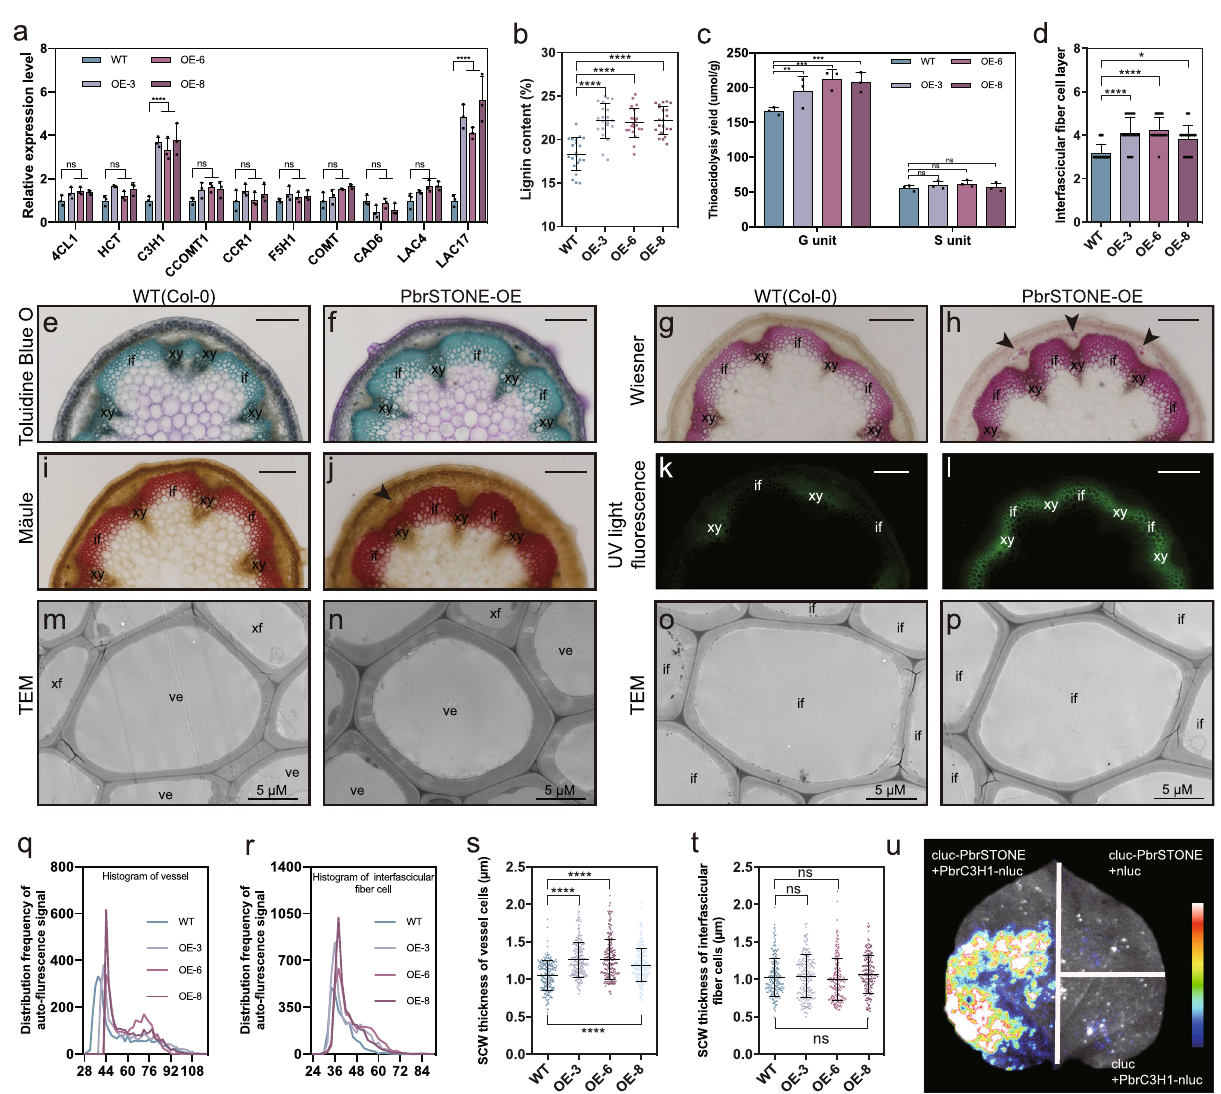
Fig. 6 Functional validation of PbrSTONE in Arabidopsis . a Expression levels of genes encoding enzymes involved in monolignol biosynthesis and polymerization in WT and PbrSTONE transgenic Arabidopsis plants using qPCR analysis; n = 3 biologically independent samples. b , c Lignin analysis for WT and PbrSTONE transgenic Arabidopsis plants; h: n = 21 biologically independent samples for b , and n = 3 for c . d Layers of stem interfascicular fi ber cells in transgenic Arabidopsis plants expressing PbrSTONE ; n = 16 biologically independent samples. e , f Cross-sections of 8-week-old in fl orescence stems stained with Toluidine blue O. g – j Cross-sections of 8-week-old in fl orescence stems stained with Mäule and Wiesner reagent, which bind to S-lignin monomer and G-lignin monomer, respectively. k , l Lignin auto- fl uorescence of cross-sections detected under UV light. Scale bars: 200 μ m in k – r . Bar in k – r = 200 μ m; xy, xylem; if, interfascicular fi ber cell. The transgenic and WT plants were cultivated two times and cross-sections were taken from fi ve independent plants which showed similar results. A representative picture from each line is shown. m – p Transmission electron micrographs of the cross-section of cells in e ; ve, vessel; xf, xylary fi ber; if, interfascicular fi ber cells. q , r Statistical analysis of lignin auto- fl uorescence signal in the vessel cells and interfascicular fi ber cells. More than 12 samples in each line were analyzed. s , t Statistical analysis of secondary cell wall thickness in the vessel cells and interfascicular fi ber cells. More than 50 cells in each line were analyzed. u Fire fl y luciferase complementation assay in young Nicotiana benthamiana leaves. Data presented are mean ± SD; p -values were determined by two-tailed Student ’ s t -test (* p < 0.05, ** p < 0.01, *** p < 0.001, **** p < 0.0001; ns, not signi fi cant). Source data underlying ( a – t ) are provided as a Source Data fi and the reads were then processed using Trimmomatic 41 to trim the adapters and using plant genomic DNA kits from TIANGEN ® . DNA quality was checked by NanoPhotometer ® spectrophotometer (IMPLEN) and 1% agarose gels, and DNA sequences with average quality per base below 20. The trimmed reads with length of at least 40bp were mapped against the reference pear genome 20 ( P. bretsch- concentration was measured by Qubit ® DNA Assay Kit in a Qubit 2.0 Flurometer (Life Technologies). NEB Next Ultra DNA Library Prep Kit for Illumina ® (NEB) neideri ) using BWA aln 42 with parameters ‘ -n 0.04 -o 1 -e 2 ’ . Genome Analysis was used to generate the sequencing libraries. The cBot Cluster Generation System Toolkit (4.1.4) was used for SNP calling with uni fi ed genotyper method 43 , and the of the HiSeq 4000 PE Cluster Kit (Illumina) was used for clustering of the index- SNPs were fi ltered using criteria of MAF ≥ 0.03 and missing rate no more than 30%. coded libraries, and the Illumina HiSeq 4000 system was used to sequence the DNA libraries (150 bp paired-end reads). F ST and ROD analysis and selective sweep detection . F ST and ROD were cal- culated using vcftools 44 with a window size of 10kb and a window step size of 5 kb, Data fi ltering and SNP calling . Quality of the 150-bp paired-end reads was and ‘ gplots ’ (https://cran.r-project.org/web/packages/gplots) in the R packages was checked by FastQC (http://www.bioinformatics.babraham.ac.uk/projects/fastqc/), applied for presentation. RNA-Seq data of landrace and improved pears 24 were